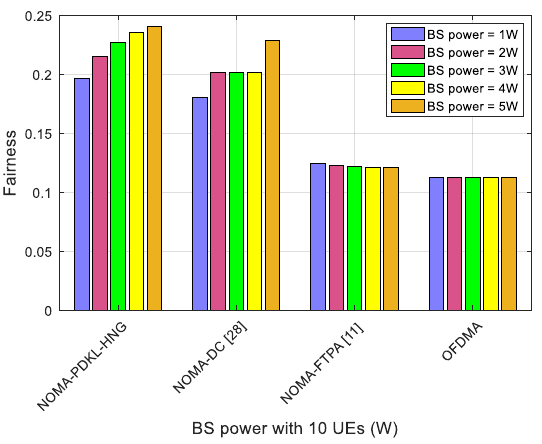
Figure 8. Fairness vs. BS power with 10 UEs.